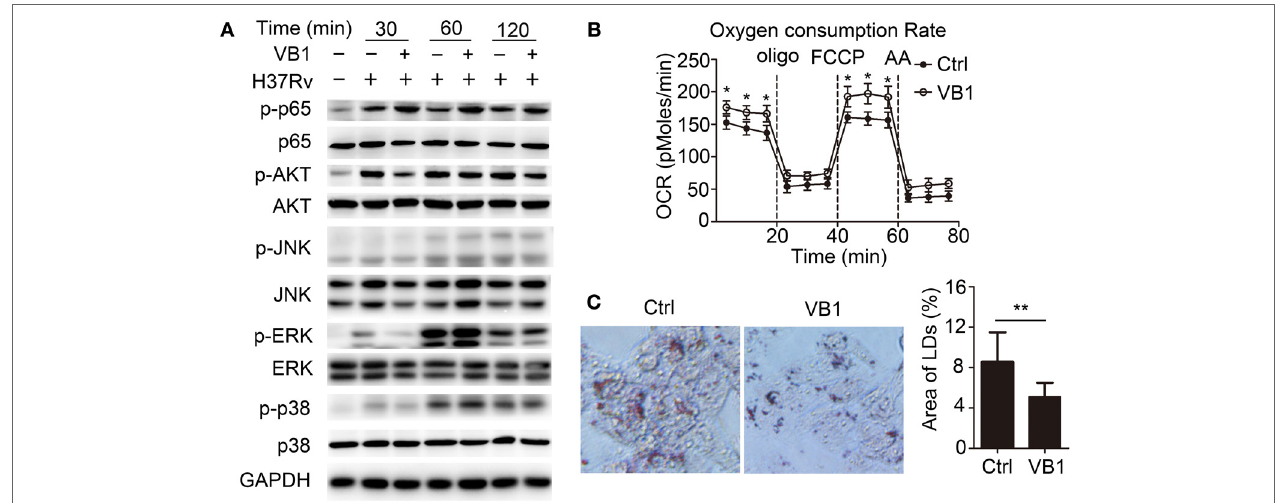
FigUre 4 | The role of vitamin B1 (VB1) in regulating signaling pathways and mitochondrial respiration. Bone marrow-derived macrophages (BMDMs) were pretreated with VB1 or phosphate buffer saline (Ctrl) for 24 h followed by Mycobacterium tuberculosis H37Rv infection (MOI 5). (a) Western blot analysis of the phosphorylation status of p65, AKT, JNK, ERK, and p38. GAPDH is as an internal control. These results are from a representative experiment ( n = 3). (B) Oxygen consumption rate (OCR) of BMDMs. O 2 consumption was normalized to protein content. oligo, oligomycin; FCCP, carbonyl cyanide 4-(trifluoromethoxy) phenylhydrazone; AA, antimycin A. (c) BMDMs were stained with Oil Red O to stain the lipid droplets. Staining was assessed by bright field microscopy and Image J software was used to calculate the total area of Oil Red O-stained droplets per cell. Original magnification × 600. Values are mean ± SD of all cells in 20 randomly selected micrographs from each group. * P < 0.05 and ** P < 0.01. Data are representative of three independent experiments with similar